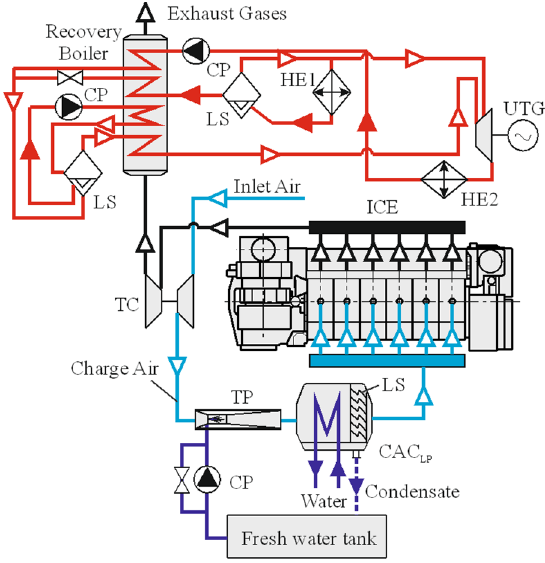
Figure 23. A scheme of a thermopressor charge-air-cooling system with integrated waste gas heat recovery in the heat-recovery boiler and UTG: LS—liquid separator; CAC LP —charge air cooler; TC—turbocharger; TP—thermopressor; HE1, HE2—heat exchangers; CP—circulation pump.